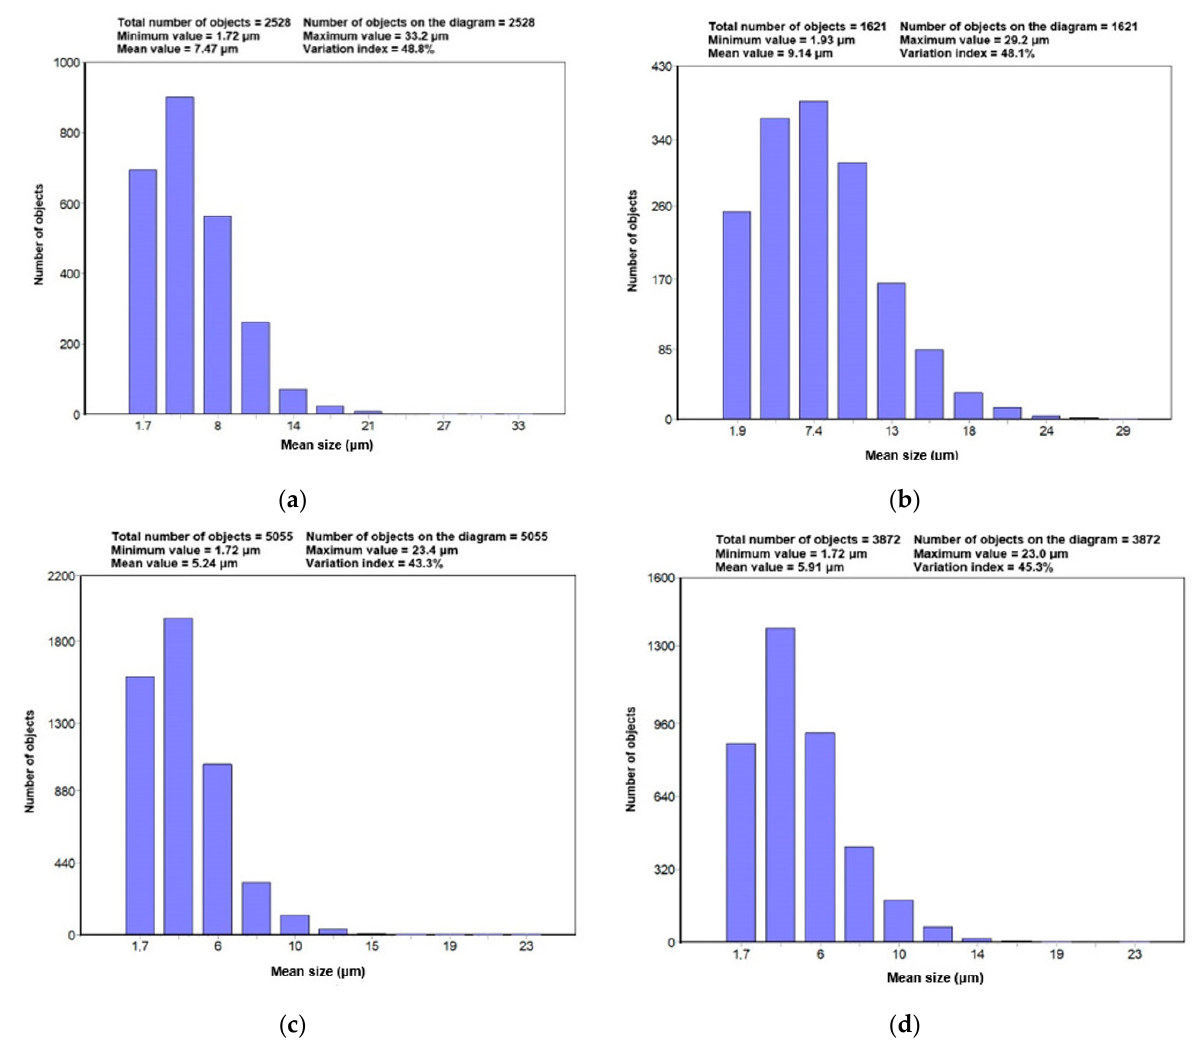
Figure 7. Diagrams of statistical distributions of mean carbide grains sizes in particular tips: ( a ) Longwall 1 tip, ( b ) Road 1 tip, ( c ) Longwall 2 tip, ( d ) Road 2 tip.